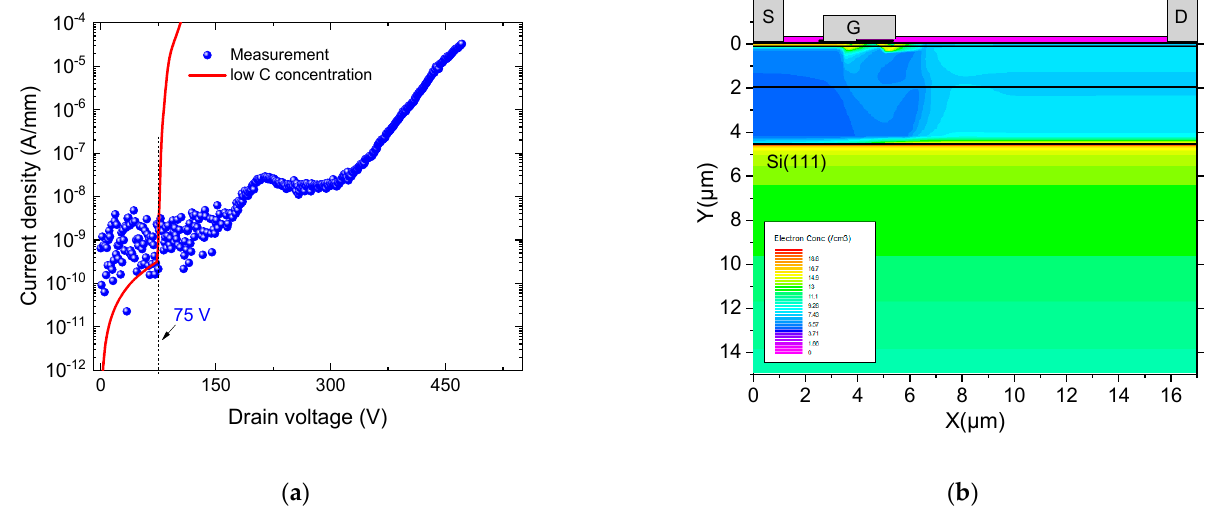
Figure 5. MOS-HEMT breakdown characteristics ( a ) Experimental (doted) and simulated (line) with low carbon concentration. Acceptor trap concentration of and 7.5 × 10 14 cm − 3 and donor trap concentration of 3.37 × 10 14 cm − 3 were considered. ( b ) MOS-HEMT structure cross section of electrons concentration at 100V showing more leakage across the buffer.